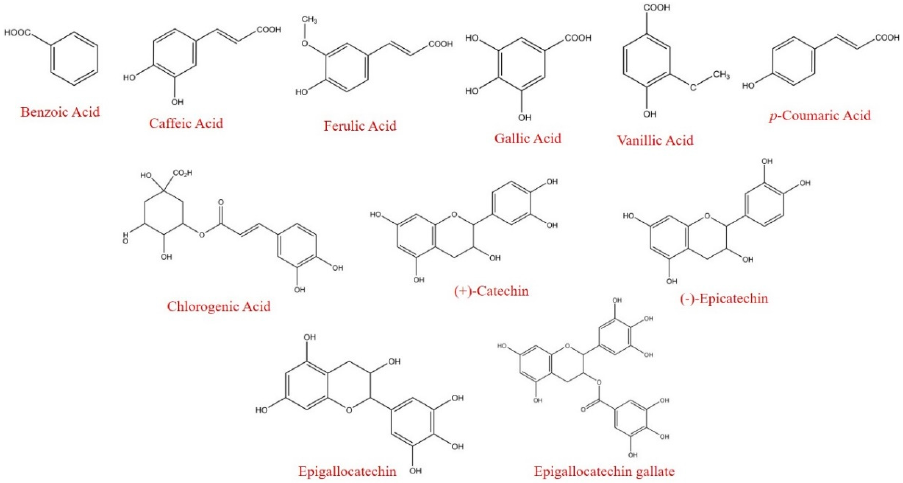
Figure 1. Chemical structures of fresh and black garlic polyphenols.